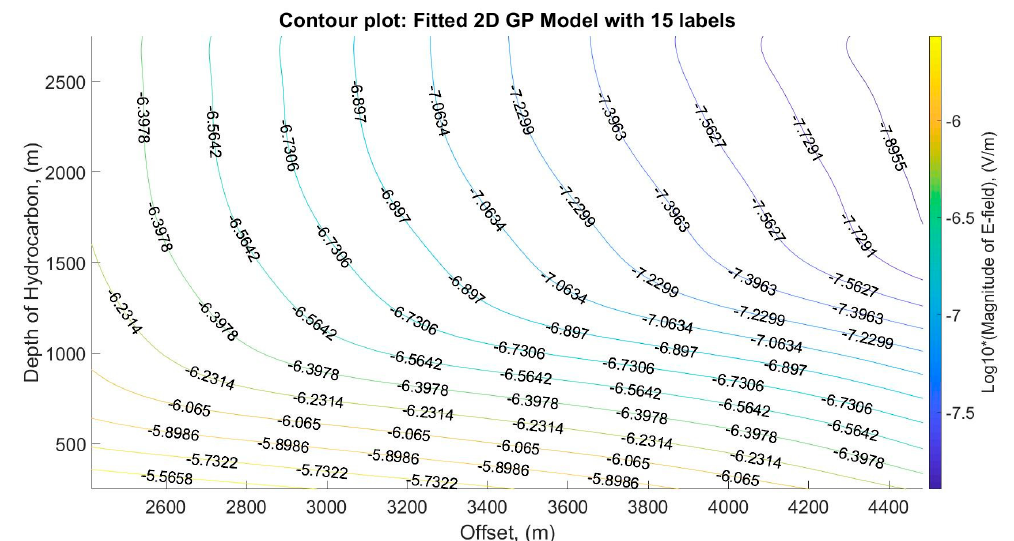
Figure 9. Contour plot of EM profiles (amplitude) for various offset distances (~2400 to ~4500 m) and hydrocarbon depths (250–2750 m) at a frequency of 0.5 Hz with 15 labels.